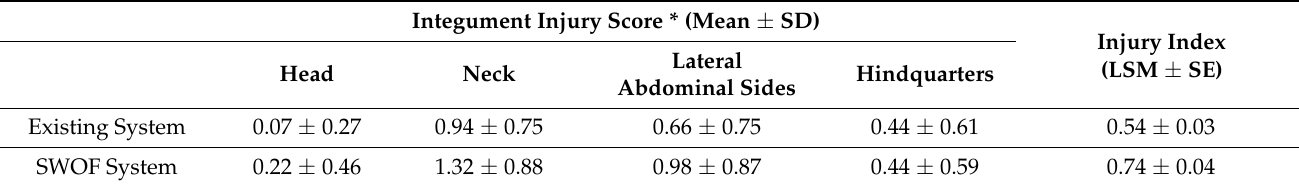
Table 5. Sows’ integument injury score per body part (mean ± SD) and injury index (LSM ± SE) in the existing and SWOF